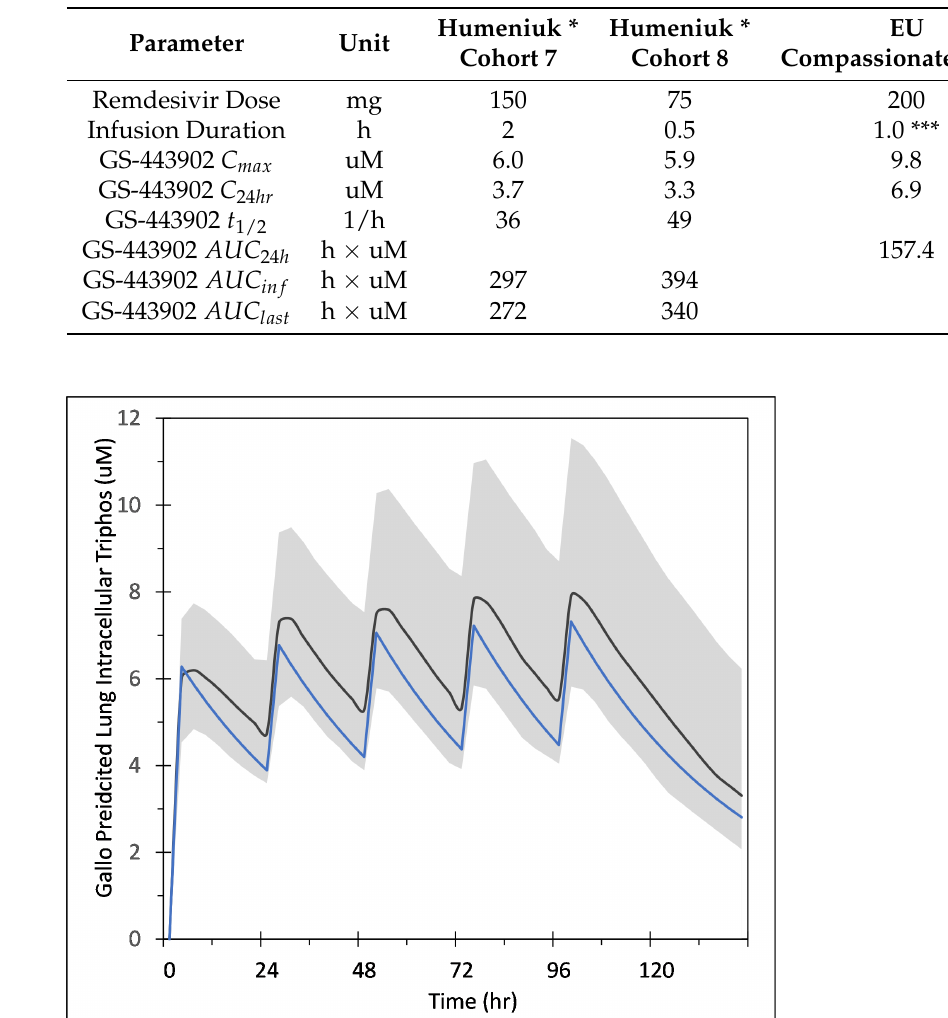
Table A1. Data used to calibrate the simple remdesivir to GS-443902 prediction model. * Humeniuk’s Table 4 in [7]; ** EU Compassionate Use’s Table 16 in [38]; *** infusion duration not given, assumed to be 1 h.